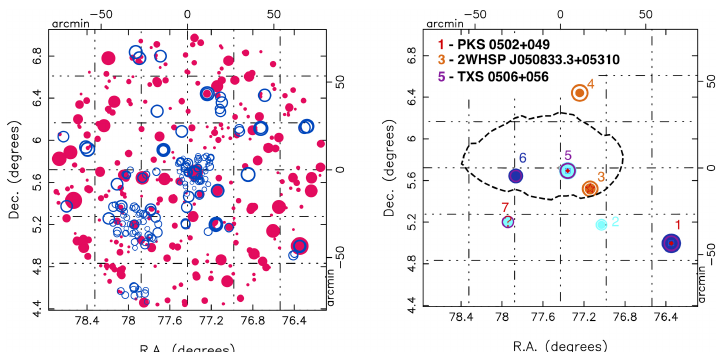
Figure 8. Left : Radio (red) and X-ray (blue) sources within 80 arcmin of the position of the IceCube-170922A event. Right : Known and candidate blazars in the same field. Dark blue circles represent low-frequency peaked BL Lac candidates, cyan symbols represent intermediate BL Lac objects, and orange symbols indicate high-frequency peaked BL Lacs. The dashed line shows the 90% error contour of the IceCube-170922 event. From [79]. Reproduced with kind permission from Oxford University Press and the Royal Astronomical